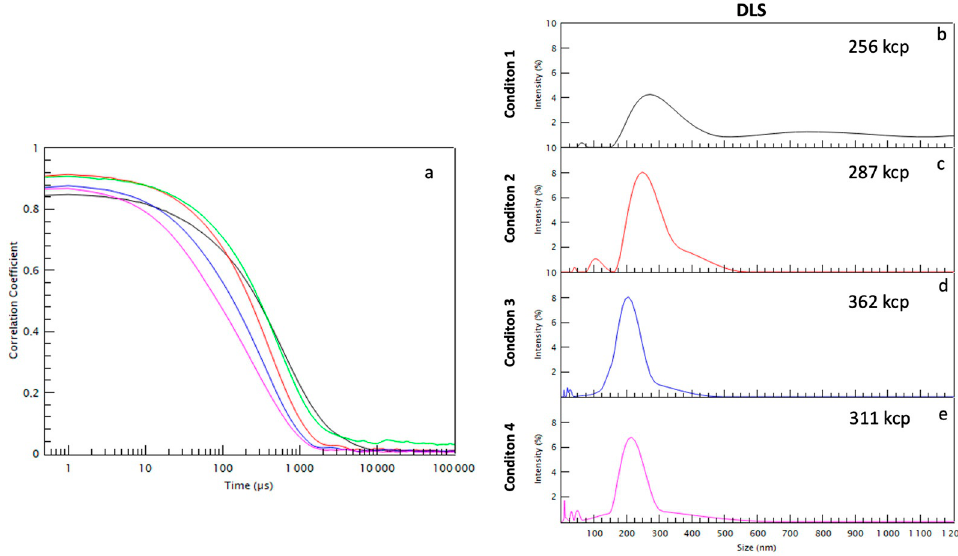
Figure 6. ( a ) Dynamic light scattering correlograms for the different conditions and ( b – e ) the corresponding size histogram in intensity for the differential centrifugation conditions (1 to 4).